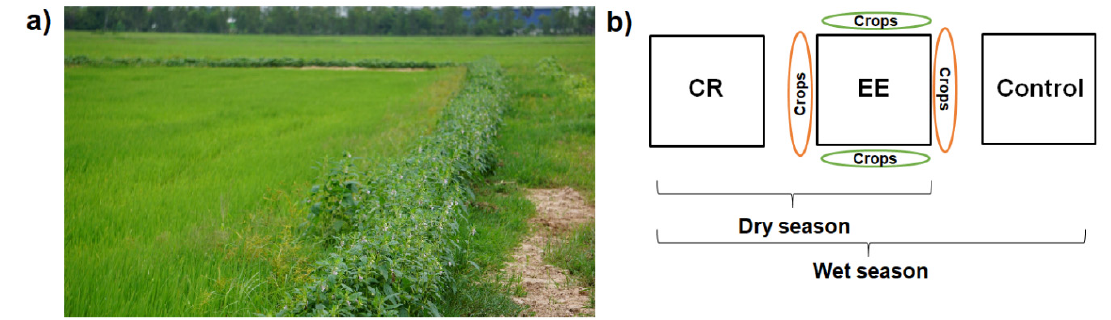
Figure 1. ( a ) Example of one ecologically engineered rice field (EE); and ( b ) the study design during the dry and wet season. Conventionally farmed rice fields (CR) were treated with pesticides, EE fields were not treated with pesticides and cultivated with additional plants on the rice bunds (earthen mound between rice fields to keep water level in the fields) and fields with no pesticides application and no bund plants served as control fields.